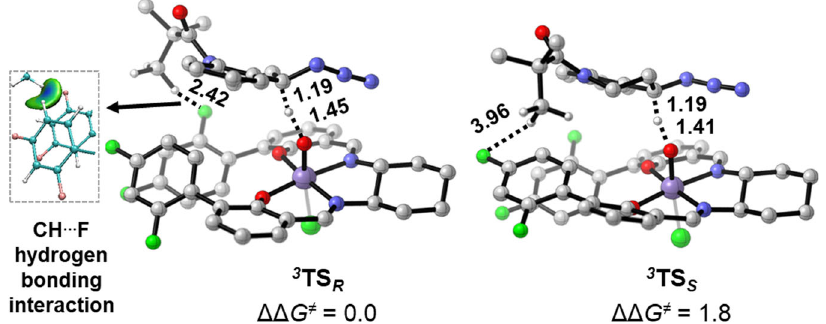
Fig. 7 Geometries and the relative Gibbs free energies of stereoselectivity-determining transition states. Trivial hydrogen atoms are omitted for clarity. The isosurface of IGM analysis is 0.005. The bond distances are given in Å. All energies are given in